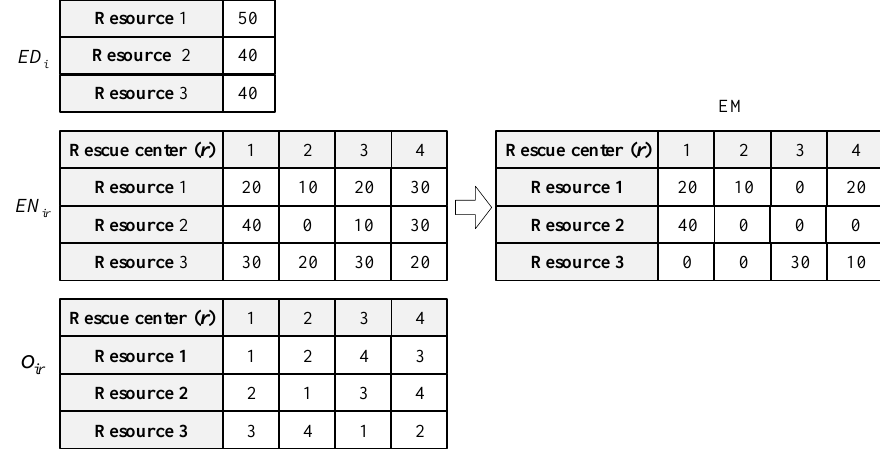
Figure 3. Illustration of sub-chromosome EM generation.